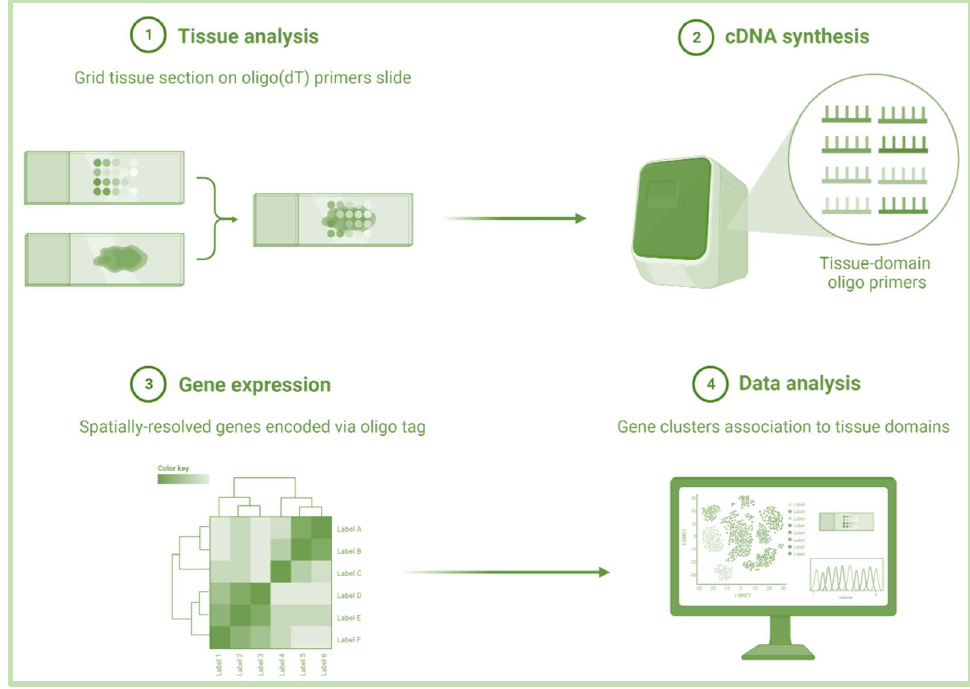
Figure 5. Spatial transcriptomics: schematic approach for fish sustainability programs.